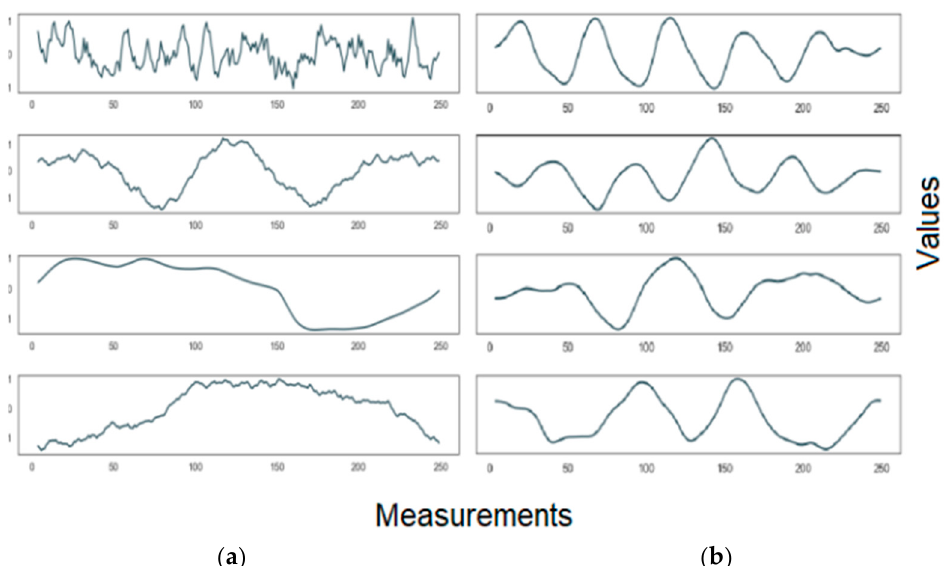
Figure 13. Maximal Convolutional Neural Network (CNN) activations for the first layer ( a ) and third layer ( b ) of the model trained for predicting speed.